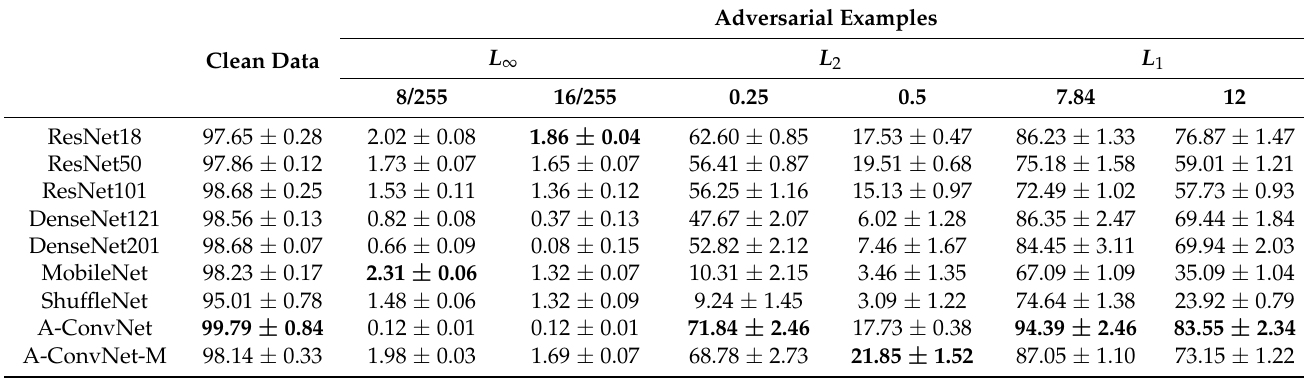
Table 3. Classification accuracy of MSTAR models against standard adversarial attack (PGD). The adversarial examples can be divided into L ∞ norm, L 2 norm, and L 1 norm limited attacks.